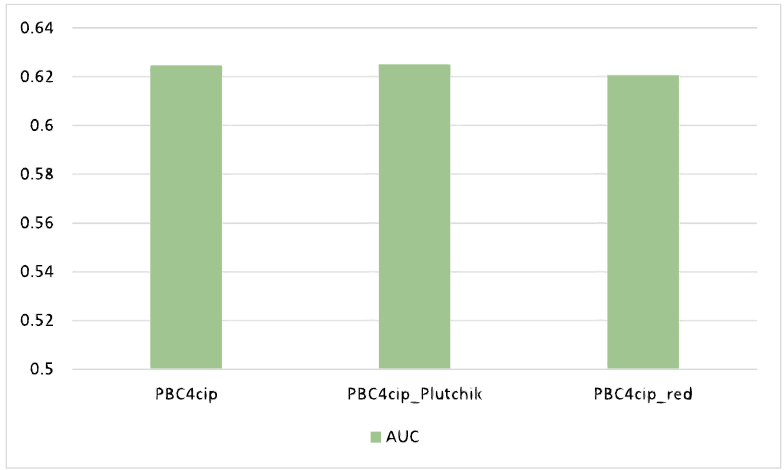
Figure 8. Performance of PBC4cip with full and modified features.